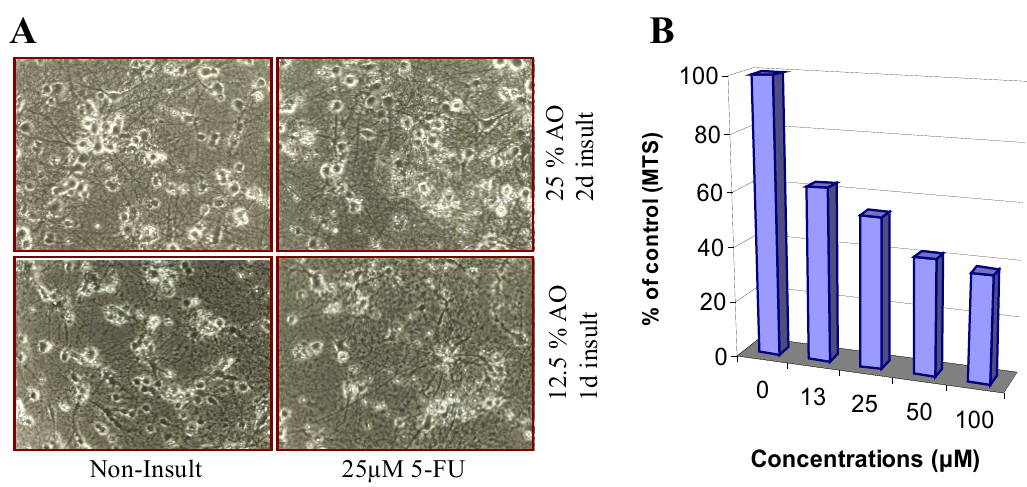
Figure 4. Effect of Antioxidants (AO) on the Neurotoxicity of 5-Fluorouracil (5-FU). ( A ) Morphological observation. Embryonic brain neurons were cultured for 13 days with concentration reduction of AO in culture medium to 25% and 12.5%, respectively. This process did not elicit cell death by itself (comparison of Non-Insult groups under higher and lower AO conditions). Treating neurons with 25 µM 5-FU did not cause observable neurotoxicity under 25% AO culture condition. However, 5-FU at the same concentration resulted in severe cell death when AO concentration was reduced to 12.5%, even for a shorter time periods. The cells were photographed under a phase-contrast microscope using a 10× objective; and ( B ) Quantification of cytotoxicity. 3-(4,5-Dimethylthiazol-2-yl)-5- (3-carboxymethoxyphenyl)-2-(4-sulfophenyl)-2 H -tetrazolium, inner salt (MTS) was used for the quantitative assay, which directly indicates an enzymatic activity of mitochondria and indirectly reflects the survival cell number. The graph shows that the neurons under reduced AO condition were vulnerable to 5-FU. Data are expressed as mean ( n = 6) percentage of Non-Insult groups (taken as 100%). 5-FU dose-dependently reduced MTS reading in reduced AO